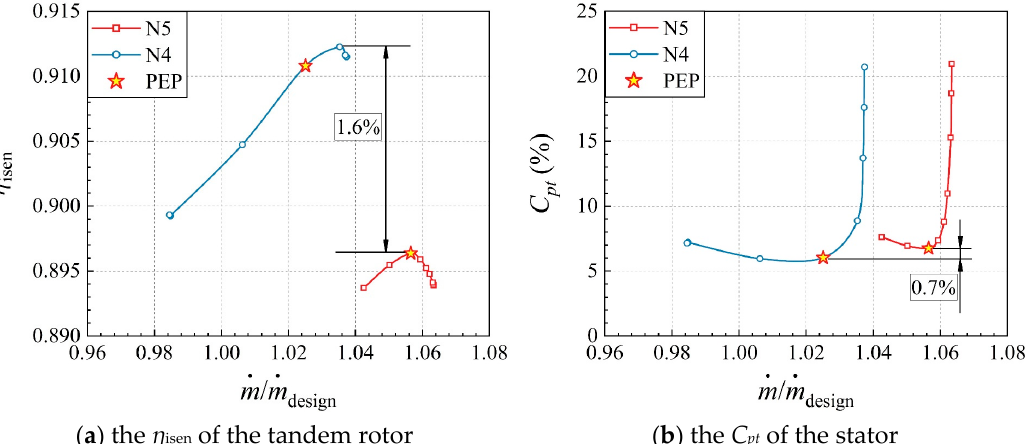
Figure 9. The aerodynamic performance of various components at N4 and N5.